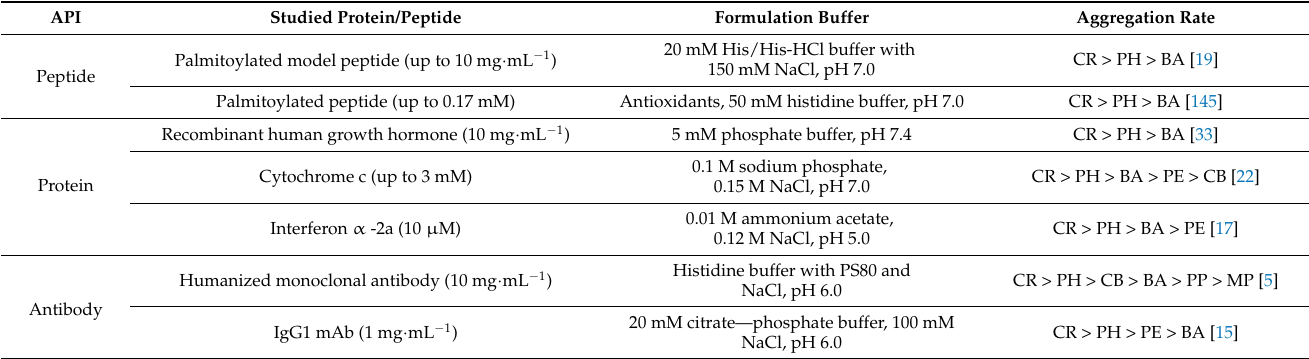
Table 14. Preservative-induced protein aggregation rate based on the results of previous